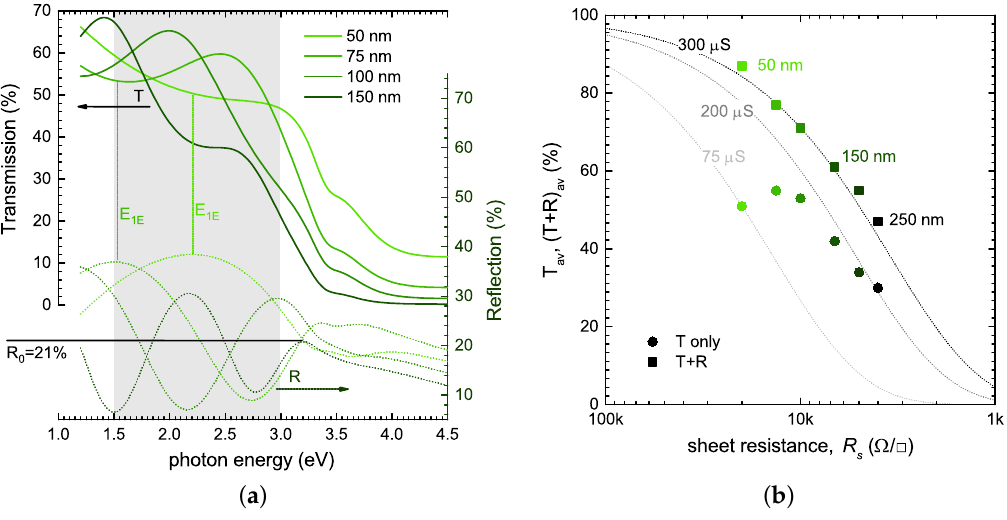
Figure 2. ( a ) Modelled transmission (—) and reflection ( ··· ) data of Cu 0.5 CrO 2 thin films on glass. The grey spectral region was used to calculate the average transmission and reflection; ( b ) The position of each film on the T av vs. R s graph using only transmission data ( • ) and T + R data ( (cid:4)